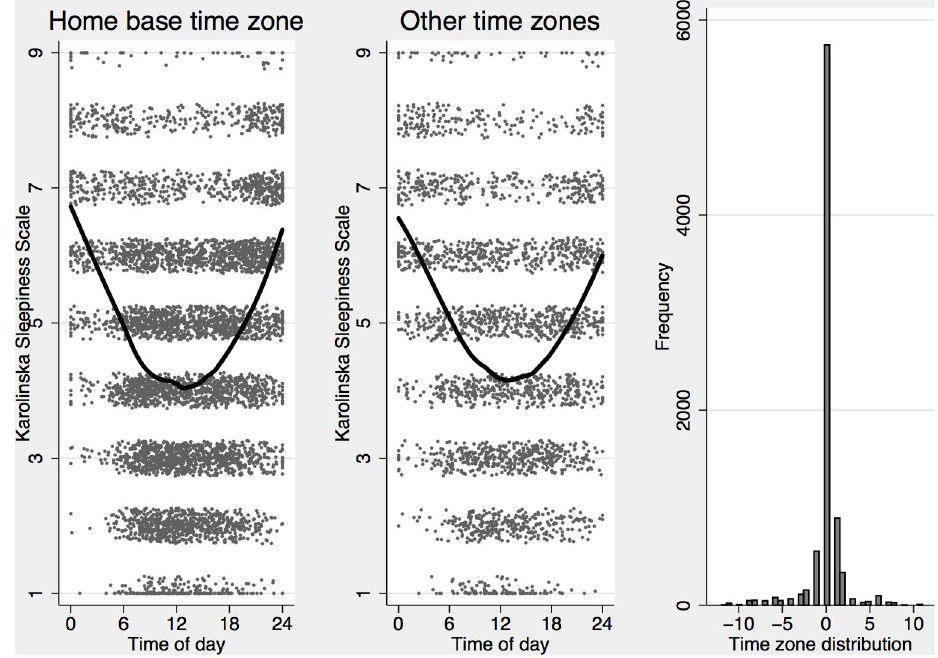
Figure 1. Observed ratings of subjective sleepiness on the Karolinska Sleepiness Scale (KSS) plotted against time of day (at home base) with a LOWESS line indicating approximate means for home base time zone (left) and other time zones (middle) with the overall distribution of time zones for all ratings (right). KSS ratings have had a random jitter applied to better illustrate the distribution at different levels.